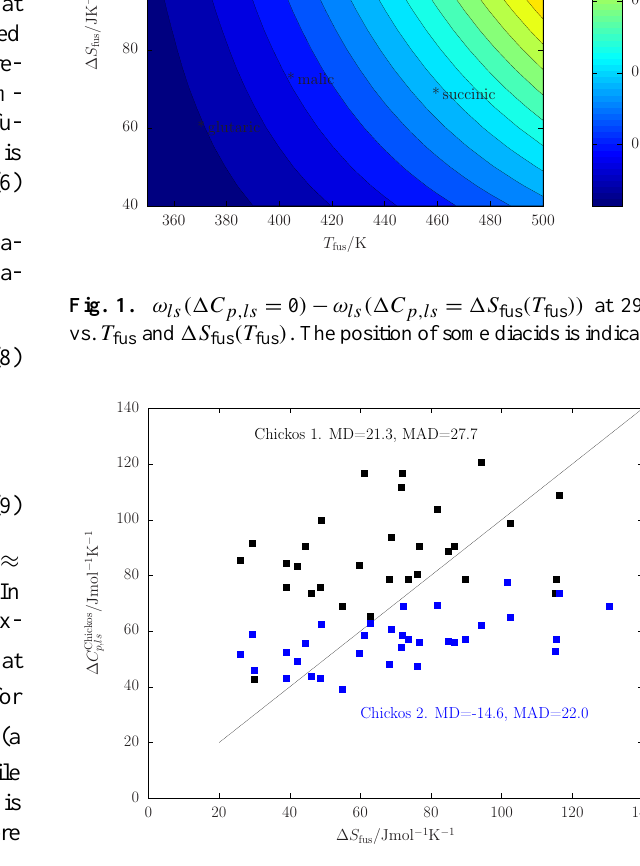
Fig. 2. ∆ C p,ls as estimated by the method of Chickos (2003) Fig. 2. 1C p,ls as estimated by the method of Chickos (2003) (Chickos1(black)and2(blue): seetextforexplanation)vs. ∆ C p,ls (Chickos 1 (black) and 2 (blue): see text for explanation) vs. 1C p,ls as approximated by ∆ S fus ( T fus ) for the compounds in our data set. The 1:1 diagonal is indicated (black line). The mean deviation and as approximated by 1S fus (T fus ) for the compounds in our data set. mean absolute deviation are also given. The 1:1 diagonal is indicated (black line). The mean deviation and mean absolute deviation are also